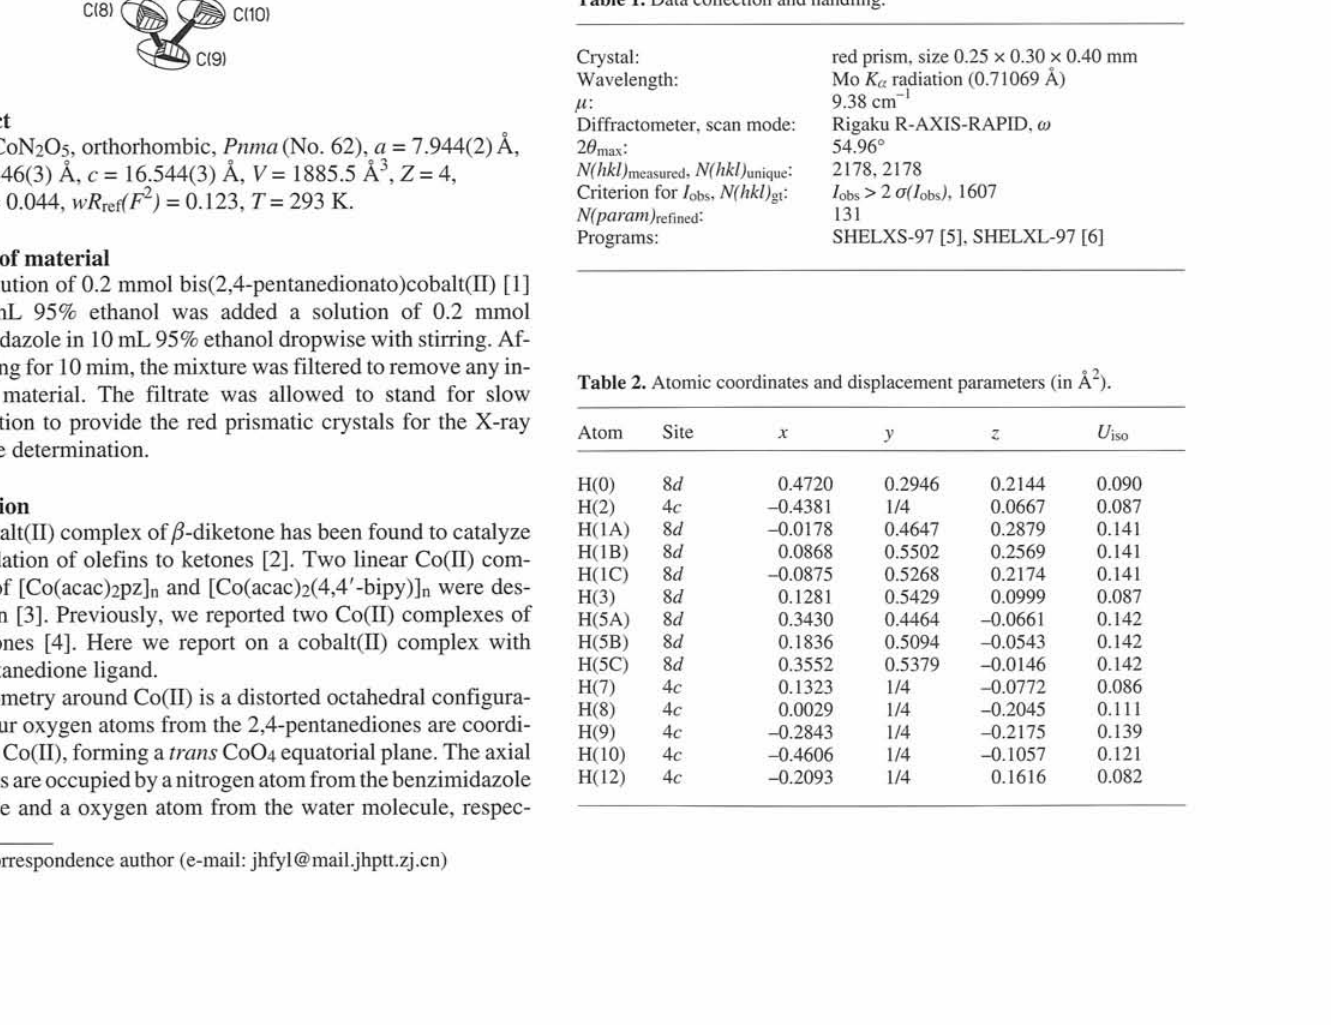
Table 1. Data collection and handling.